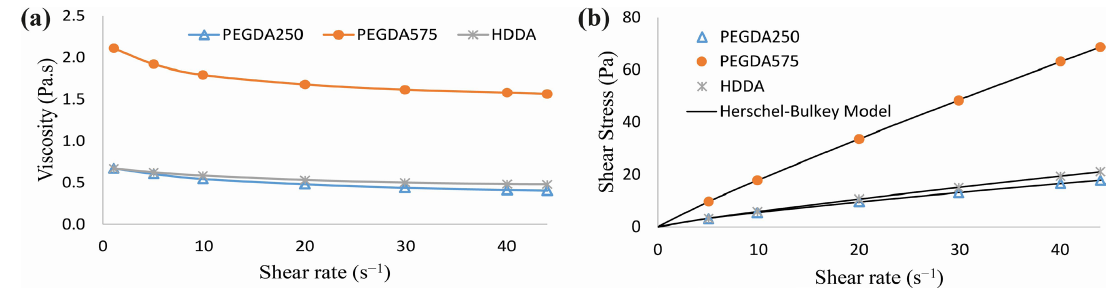
Figure 3. Rheological behavior of ceramic slurries with 30 vol% solid loading (a) viscosity curve with different monomers (b) Shear stress vs shear rate with different monomers fitted by the Herschel-Bulkley model.